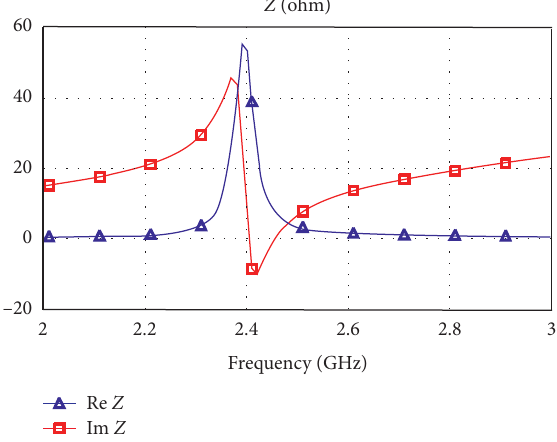
Figure 6: Patch antenna impedance Z vs.